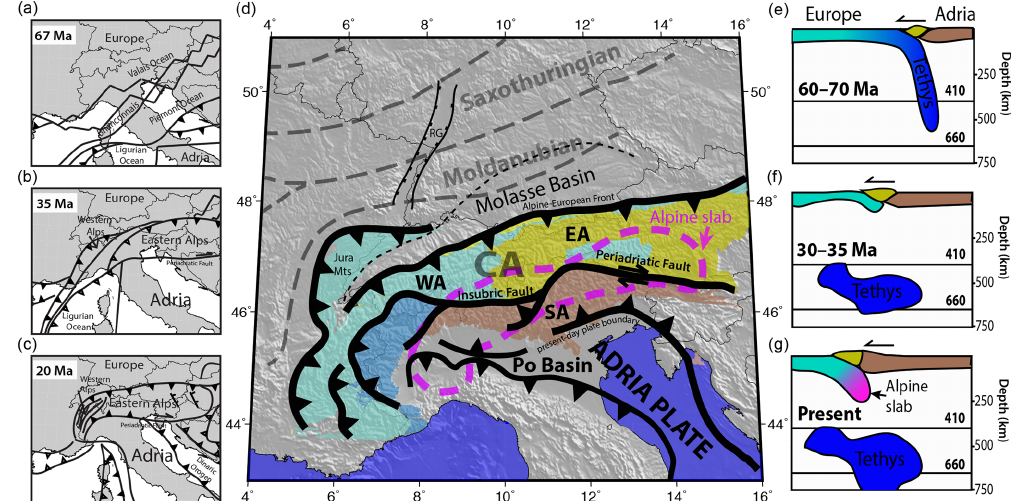
Figure 1. Geographical units of the Alpine chain and surrounding regions. Coloured areas representing the main geological regions are based on Schmid et al. (2008) and mark the Eastern Alps (EA, yellow), the Southern Alps (SA, brown), and the Western Alps (WA, light and dark blue). TW: Tauern window. Dashed pink line marks the probable outline of the Alpine slab, after Mitterbauer et al. (2011). (a–c) Plate tectonic reconstruction snapshots of the region for the past 67Ma, according to Handy et al. (2010). (e–g) Time-lapse images of probable trench migration and slab break-off beneath the Alps for the past 70Ma, after Piromallo and Faccenna (2004). The section showing the Alpine slab (pink), attached to the European lithosphere (cyan), may only be applicable to the Western Alps and Central Alps. In the Eastern Alps, the slab may be attached to Adria (yellow and brown).